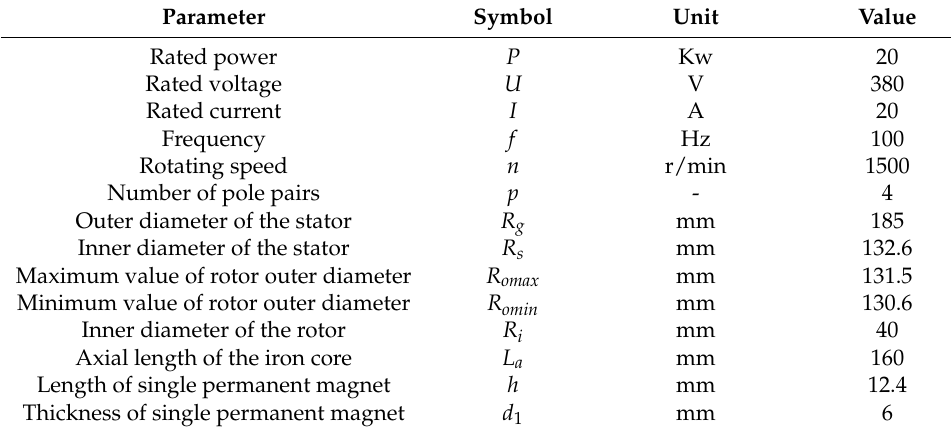
Figure 4. Schematic diagram of IPMSMA. Table 2. The basic parameters of IPMSMA.